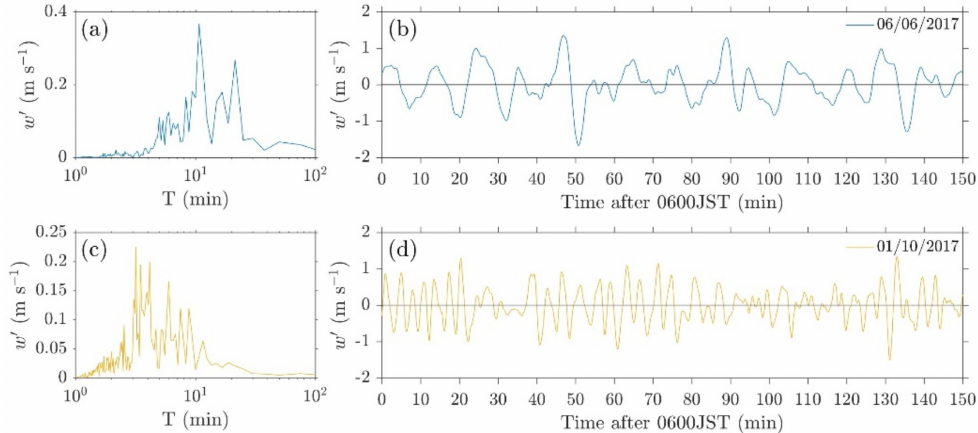
Figure 5. Doppler lidar observations of perturbation vertical velocity ( w (cid:48) ) between 0600–0830 JST: ( a , c ), w (cid:48) amplitude against period ( T ), ( b , d ), w (cid:48) against